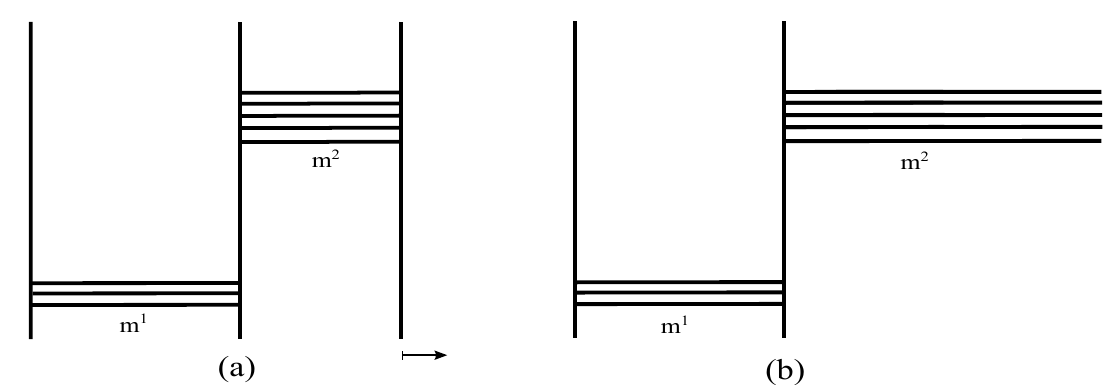
Figure 1 . This (cid:12)gure demonstrates the brane construction of line defects in PSU(2) gauge theory from SU(3) gauge theory. (a) shows the fundamental monopoles in the SU(3) theory. By taking the rightmost brane to in(cid:12)nity, we arrive at (b) with line defects in the PSU(2)